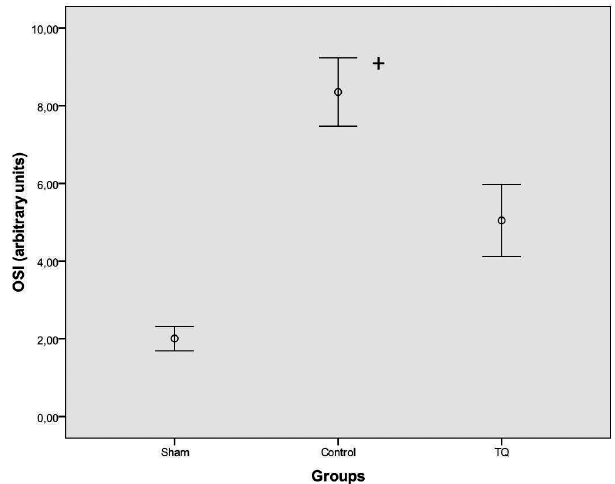
Fig. 3 - OSI levels in sham, control, and thymoquinine groups. +P<0.001 (for all comparisons) compared with sham and thymoquinine